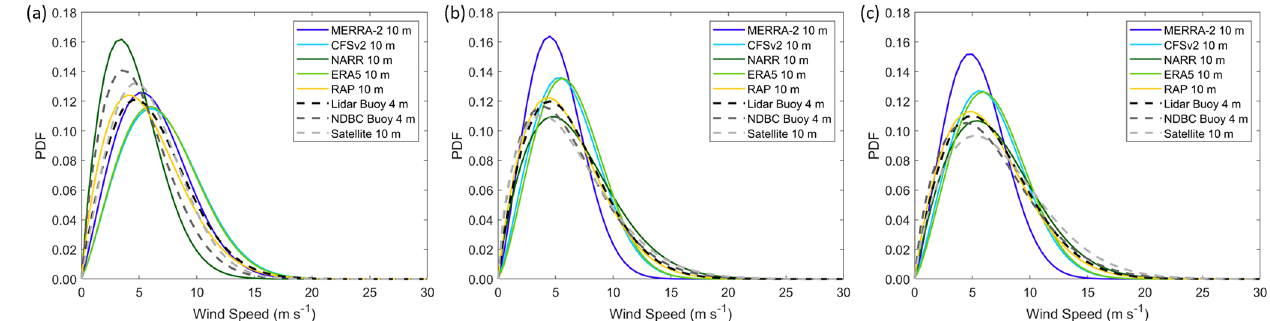
Figure 6. Weibull fits to near-surface observed, modeled, and satellite winds at (a) Humboldt, (b) Morro Bay during the overlapping Humboldt period, and (c) Morro Bay during the full seasonal